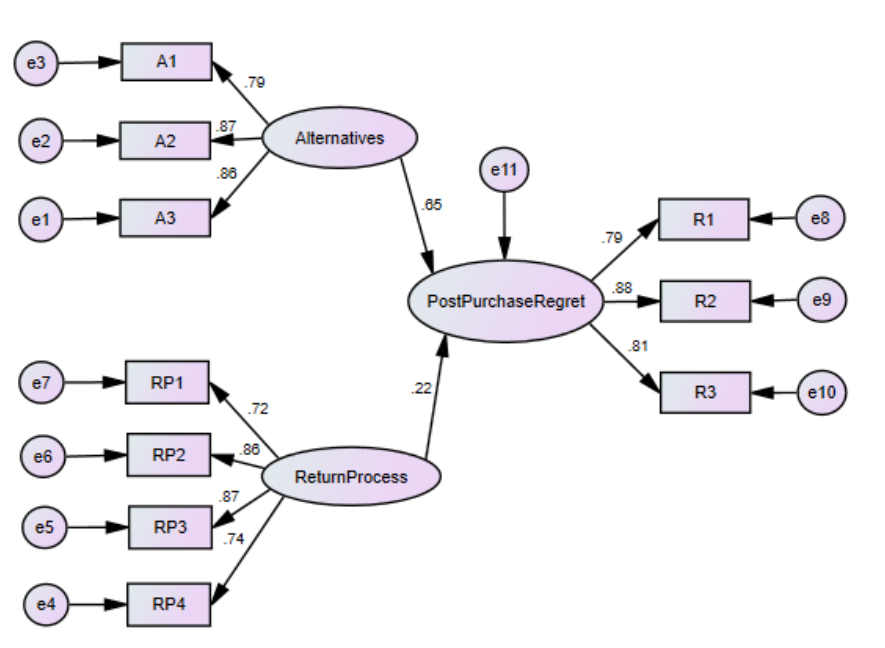
Figure 2: Empirical Casual Model (SEM) using AMOS